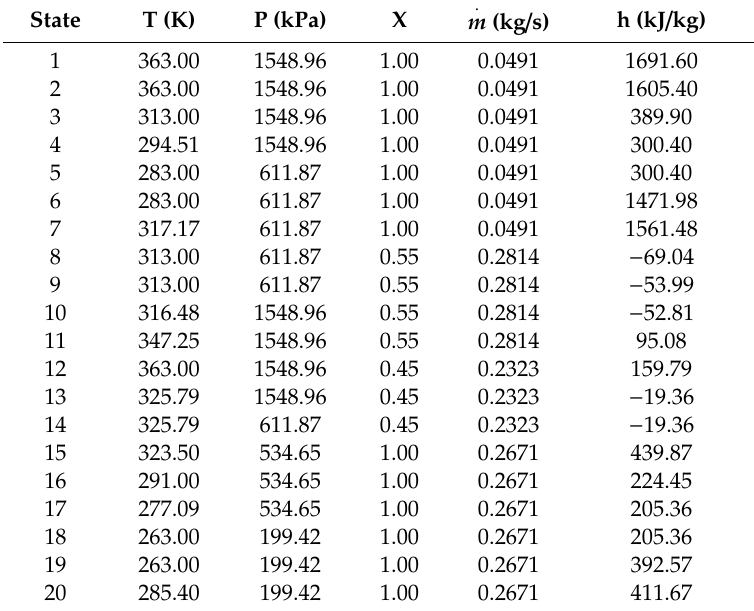
Table 5. Thermodynamic data of the compression–absorption cascade system using NH 3 -H 2 O solution and R134a as working